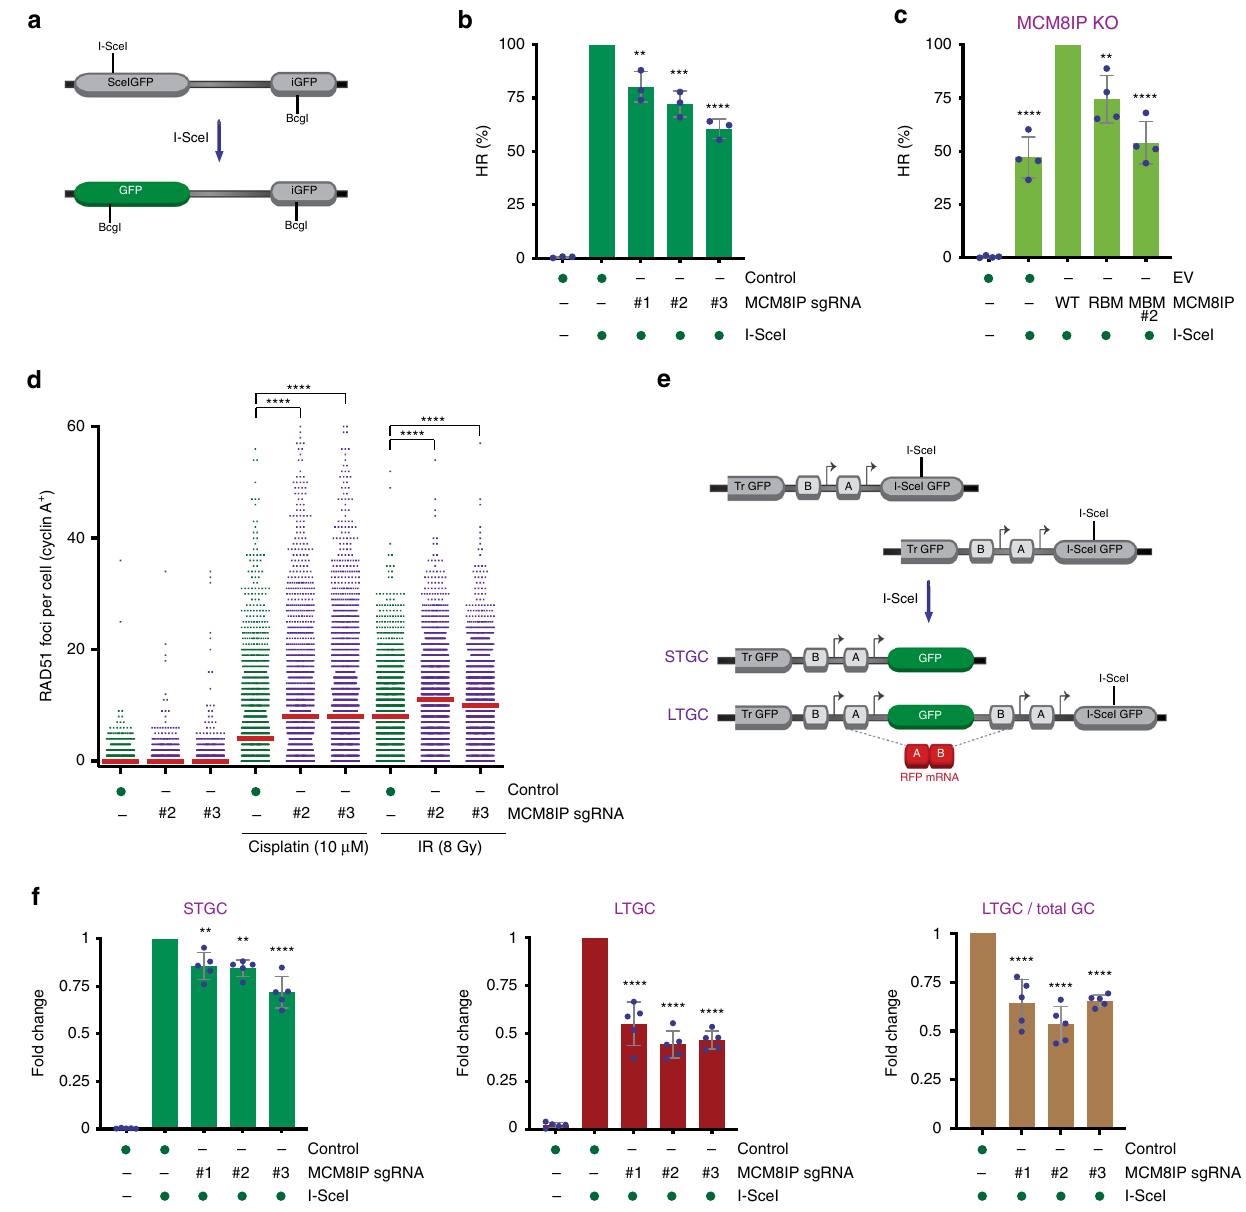
Fig. 5 Homologous recombination frequency in MCM8IP-de fi cient cells. a Schematic representation of the DR-GFP reporter of gene conversion, as described 80 . b Graphical representation of the percentage of I-SceI-induced HR events in U2OS DR-GFP cells expressing the indicated MCM8IP sgRNAs relative to control cells. The relative level of background events in control cells transfected with an empty vector is additionally shown. The mean ± SD of three independent experiments is presented. Statistical analysis relative to the control was conducted using one-way ANOVA (** p < 0.01, *** p < 0.001, **** p < 0.0001). c Graphical representation of the percentage of I-SceI-induced HR events in an U2OS DR-GFP MCM8IP KO clone reconstituted with the indicated cDNAs or an empty vector (EV) control, as shown in Supplementary Fig. 6d, e, relative to WT MCM8IP-expressing KO cells. The relative level of background events in EV-complemented cells transfected with an empty vector is additionally shown. The mean ± SD of four independent experiments is presented. Statistical analysis relative to WT MCM8IP-expressing KO cells was conducted as in ( b ) (** p < 0.01, **** p < 0.0001). d Dot plot of the number of cisplatin- or ionizing radiation-induced RAD51 foci in cyclin A-positive HCT116 control cells or cells expressing the indicated MCM8IP sgRNAs. The median values are indicated by red lines within the dot plot. Data are representative of two independent experiments. Statistical analysis was conducted using a Mann – Whitney test (**** p < 0.0001, two-tailed). e Schematic representation of the SCR/RFP reporter of gene conversion, as described 44 . Blocks A and B are arti fi cial RFP exons and arrows are promoters. Short-tract gene conversion (STGC) results in GFP expression alone, while long-tract gene conversion (LTGC) results in the additional expression of RFP. f Graphical representation of the fold change in I-SceI-induced STGC (left panel), LTGC (middle panel), and LTGC as a fraction of total gene conversion events (right panel) in U2OS 35S cells expressing the indicated MCM8IP sgRNAs relative to control cells. Relative levels of background STGC and LTGC events in U2OS 35S control cells transfected with an empty vector are additionally shown. The mean ± SD of fi ve independent experiments is presented. Statistical analysis was conducted as in ( b ) (** p < 0.01, **** p <